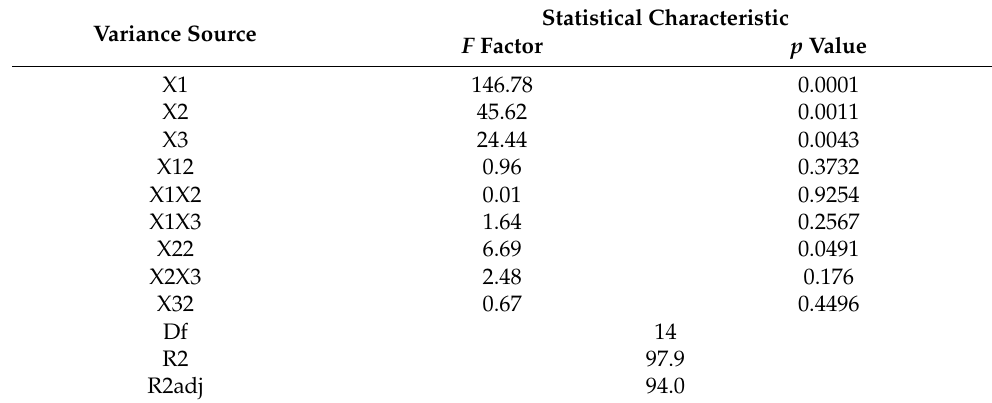
Table 4. Result of the variance